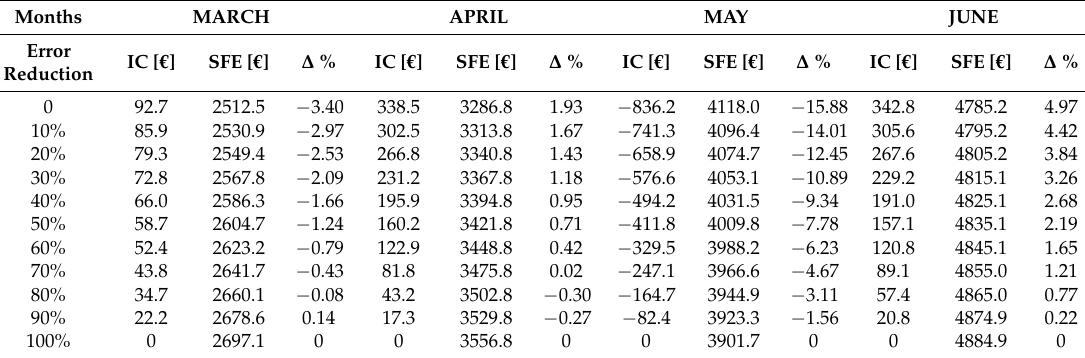
Table 4. Example of imbalance data and payments for a typical March